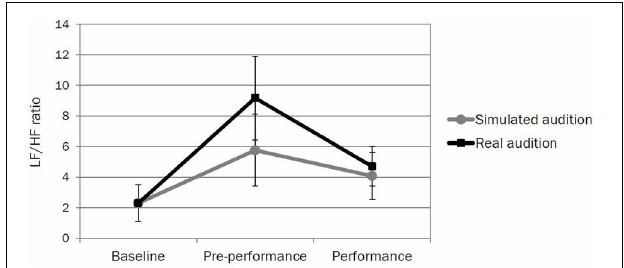
FIGURE 4 | The mean LF/HF ratio (with SD ) calculated from ECG data collected for the violinists at baseline, pre-performance, and during performance for the simulated and real